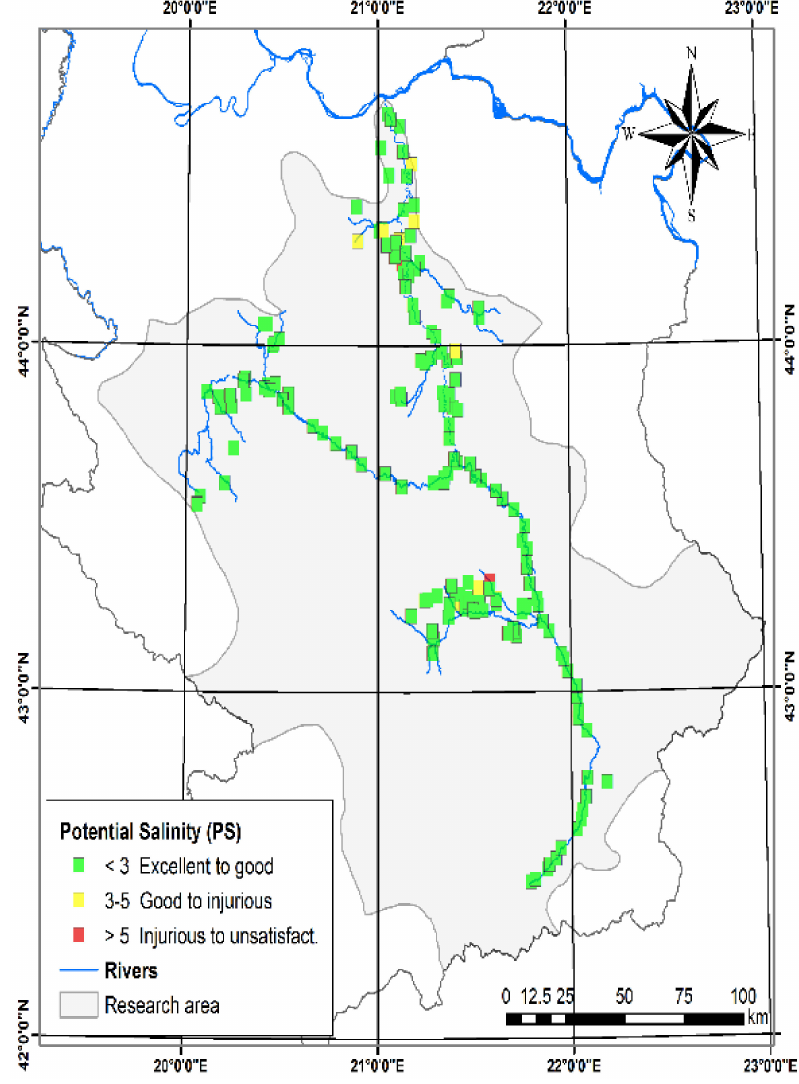
Figure 15. Spatial distribution of